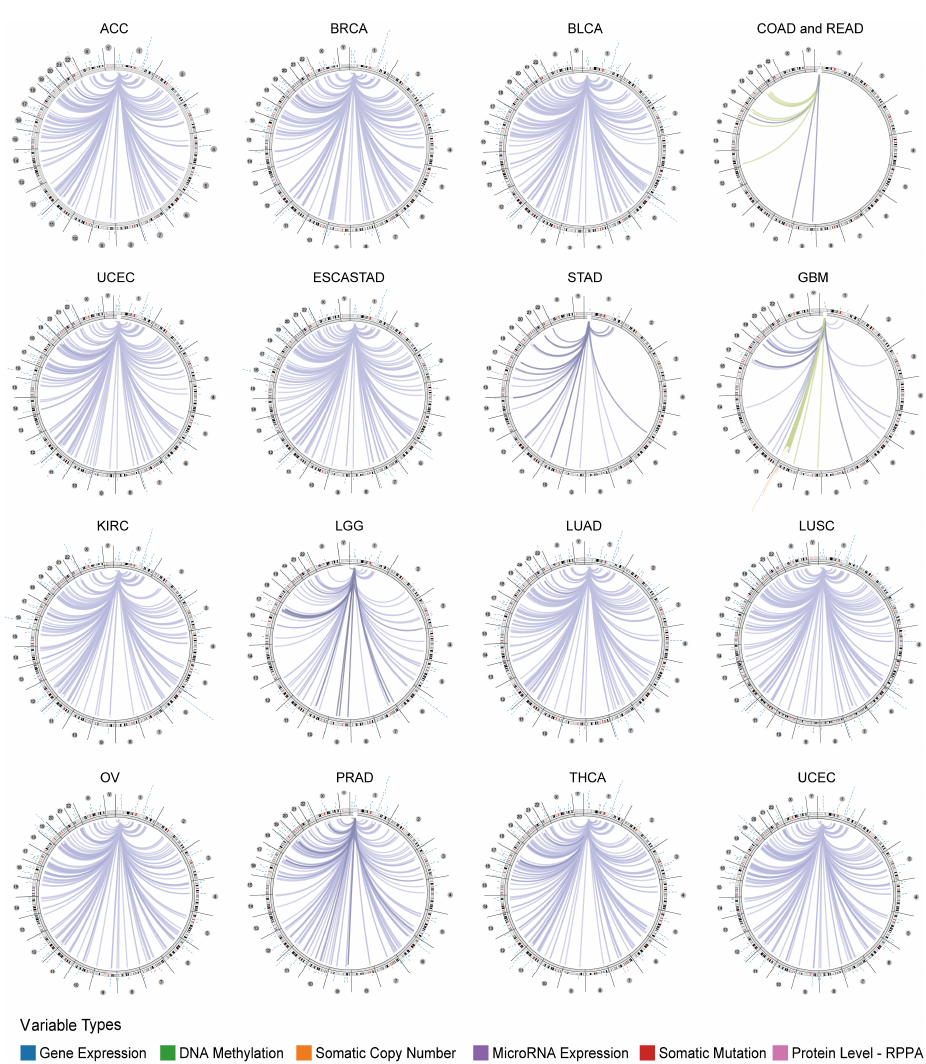
Figure 6. Genome-wide correlation analysis between LCK and other signatures of cancer samples from the Cancer Regulome program of The Cancer Genome Atlas database.